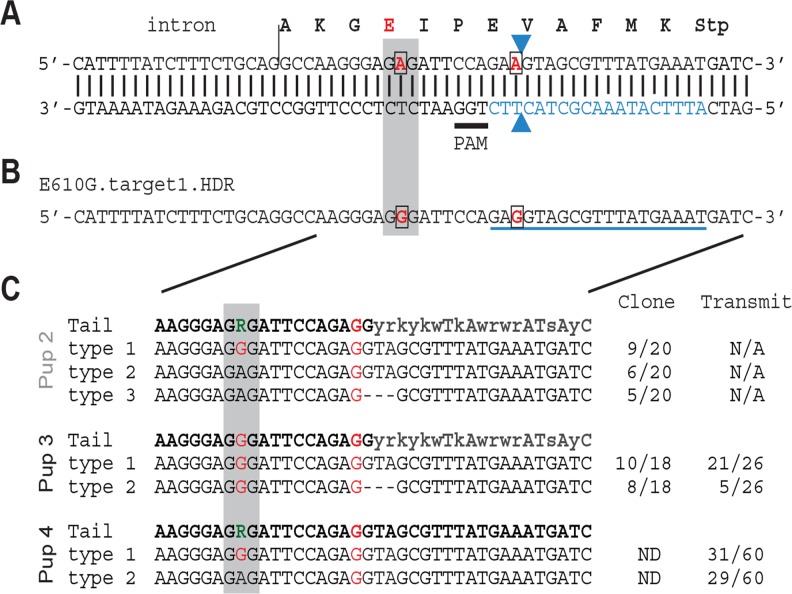

Nxf1 E610G genome editing in mouse embryos.
(A) Translation and genomic sequence surrounding E610G targeted for editing. Codon 610 is shaded grey, targeted bases are in red and boxed, guide RNA sequence is in blue, the presumed Cas9 cut site shown by arrowheads, and the PAM sequence is underlined. (B) Partial sequence of the repair template oligonucleotide shows the two targeted base changes, including one in the guide RNA sequence. (C) Sequences obtained by PCR from tail DNA of one dead (Pup 2) and two live (Pups 3 and 4) G0 pups. Sequence from cloned PCR products (Pups 2 and 3) confirmed an equivalent 3-bp deletion (ΔVal) on one allele in each animal. Sequence from offspring confirmed transmission of each edited allele from the two viable founders.